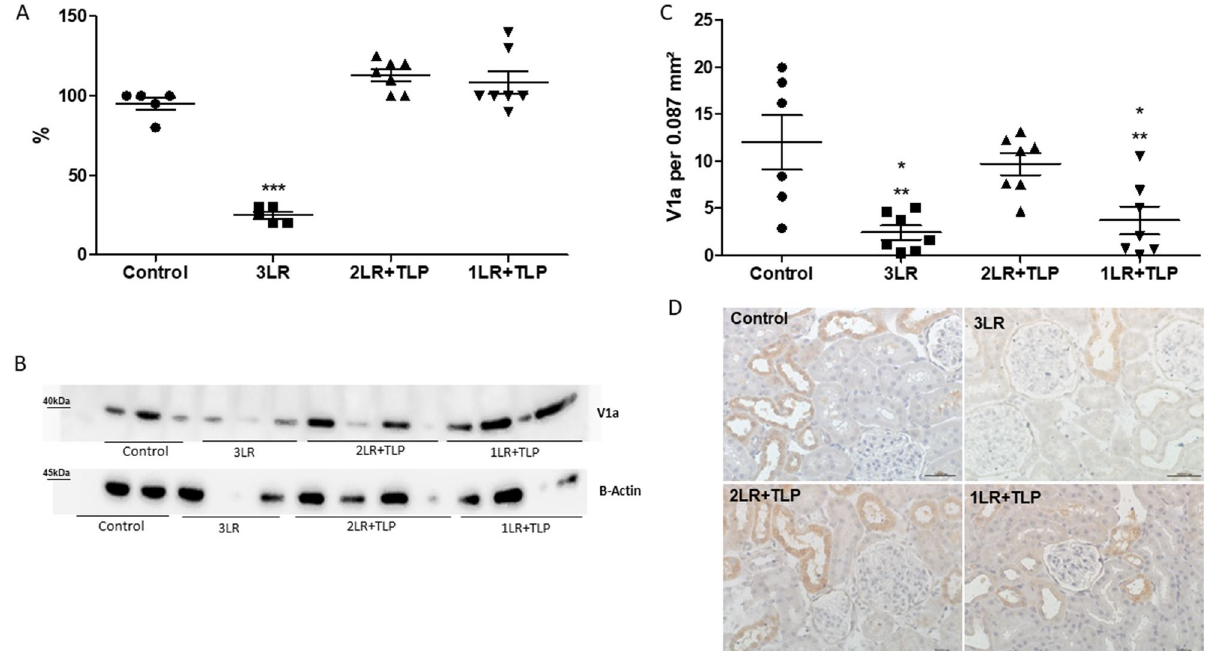
Figure 9. Arginine vasopressin 1a receptor (V1aR) expression in the renal tissue at 24 h after hemorrhagic shock induction. Immunohistochemical analysis of V1aR expression in rat kidney tissue at 24 h after hemorrhagic shock induction, by densitometric analysis ( A ) and immunoblotting ( B ) (Supplementary Fig. 3). Bar graph of V1aR expression ( C ) and immunostaining [brown, in ( D )] for V1aR in kidney cortex samples from control, 3LR, 2LR + TLP, and 1LR + TLP group rats. Magnification, × 40. *** P < 0.001 vs. control, 2LR + TLP, and 1LR + TLP. * P < 0.05 vs. 2LR + TLP; ** P < 0.01 vs. control; Control, no intervention; 3LR, induction of hemorrhagic shock, followed by infusion of lactated Ringer’s at 3 times the volume of the blood withdrawn; 2LR + TLP, induction of hemorrhagic shock, followed by infusion of lactated Ringer’s at 2 times the volume of the blood withdrawn, together with intravenous injection of terlipressin at 10 µg/100 g body weight; 1LR + TLP, induction of hemorrhagic shock, followed by infusion of lactated Ringer’s at a volume equal to that of the blood withdrawn, together with intravenous injection of terlipressin at 10 µg/100 g body